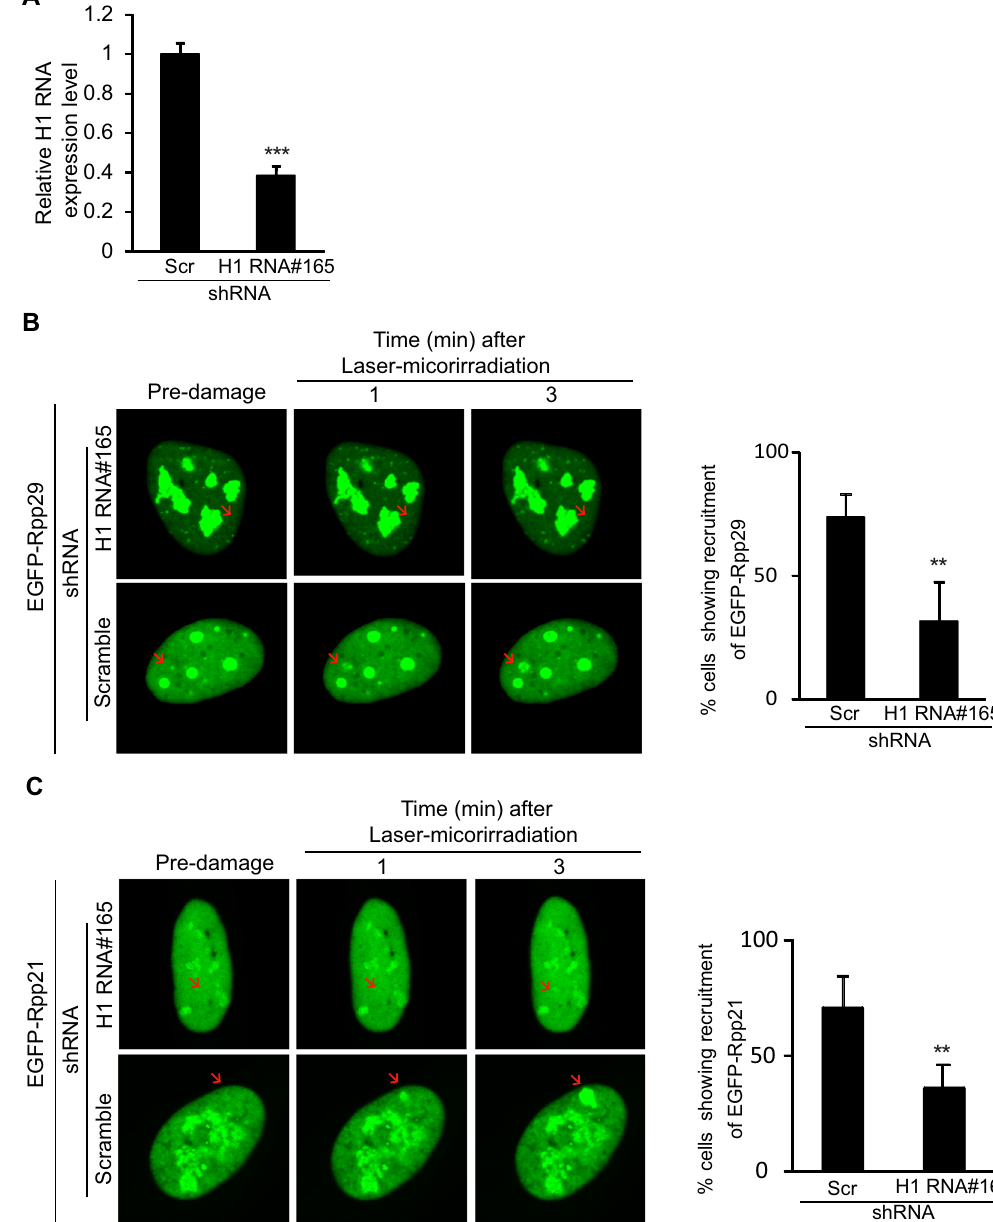
Figure 7. Knockdown of H1 RNA inhibits the recruitment of EGFP-Rpp29 and EGFP-Rpp21 to laser- microirradiated sites. ( A ) TaqMan-based Real-Time PCR shows ~65% knockdown of H1 RNA. RNA was extracted from U2OS cells transfected with either a scramble shRNA or H1 RNA shRNA#165. Real-time PCR was performed to measure H1 RNA level. The y-axis represents the relative RNA level of H1 RNA, which was normalized to that of GAPDH. Error bars represent the SEM from two independent experiments. ( B , C ) Recruitment of EGFP-Rpp29 ( B ) and EGFP-Rpp21 ( C ) to DNA damage sites cells with shRNA knockdown of H1 RNA or control cells expressing a scramble shRNA. Graphs display the percentage of cells exhibiting accumulation of the two fusion proteins at DNA damage sites. Error bars show the SEM from two independent experiments and represent at least 30 different cells. P-values were calculated by two-sided Student’s t-test relative to scramble shRNA; ** and *** indicates significance of p < 0.01 and